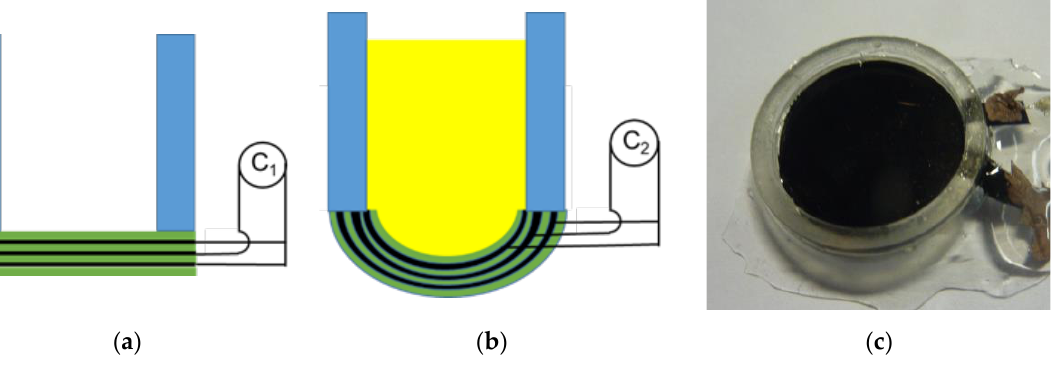
Figure 13. Out-of-plane DE strain sensor with two dielectric layers, three electrode layers and two outer protective layers at the bottom of a tube in a schematical representation in side view in the unloaded state ( a ) and in a loaded state with liquid pressure in the tube ( b ) and as a photograph ( c ) [102].